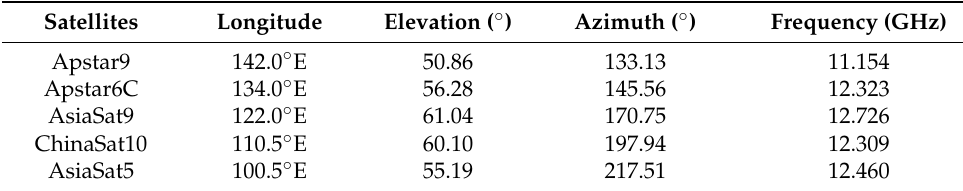
Table 1. The parameters of the geostationary satellites for building the ESLs.